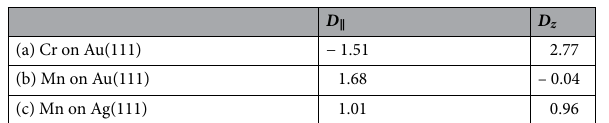
Table 1. The strength of the in-plane and out-of-plane components of the DMI vector, in meV. Note that (a), (b) and (c) denotes the systems shown in Fig. 1 of a triangular trimer of Cr on Au(111) surface, Mn on Au(111) and Ag(111) surfaces, respectively. The DMI calculations were performed for magnetic moments in a ferromagnetic configuration, with the magnetic moments pointing perpendicular to the surface.